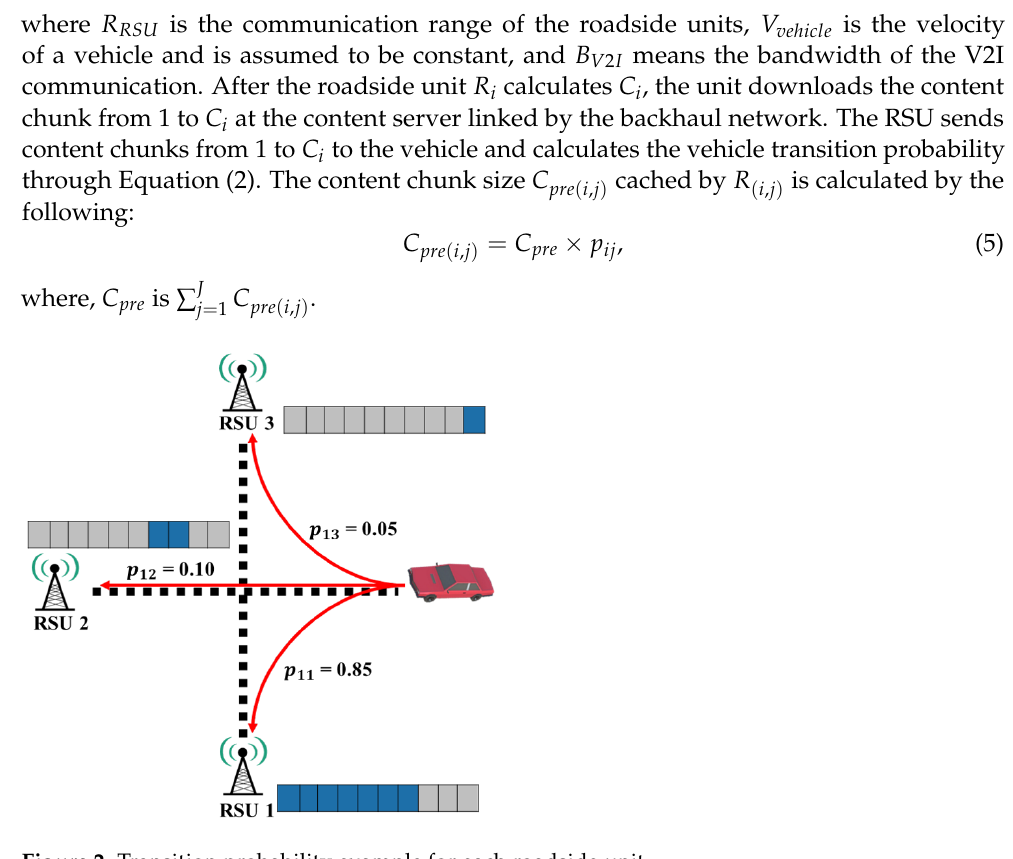
Figure 2. Transition probability example for each roadside unit. Table 1. Content caching